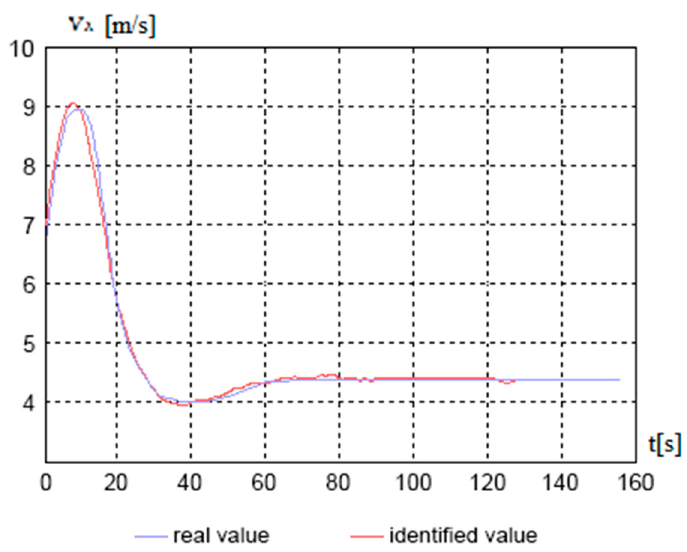
Figure 3. Estimation of the V y component of the velocity during circulation.